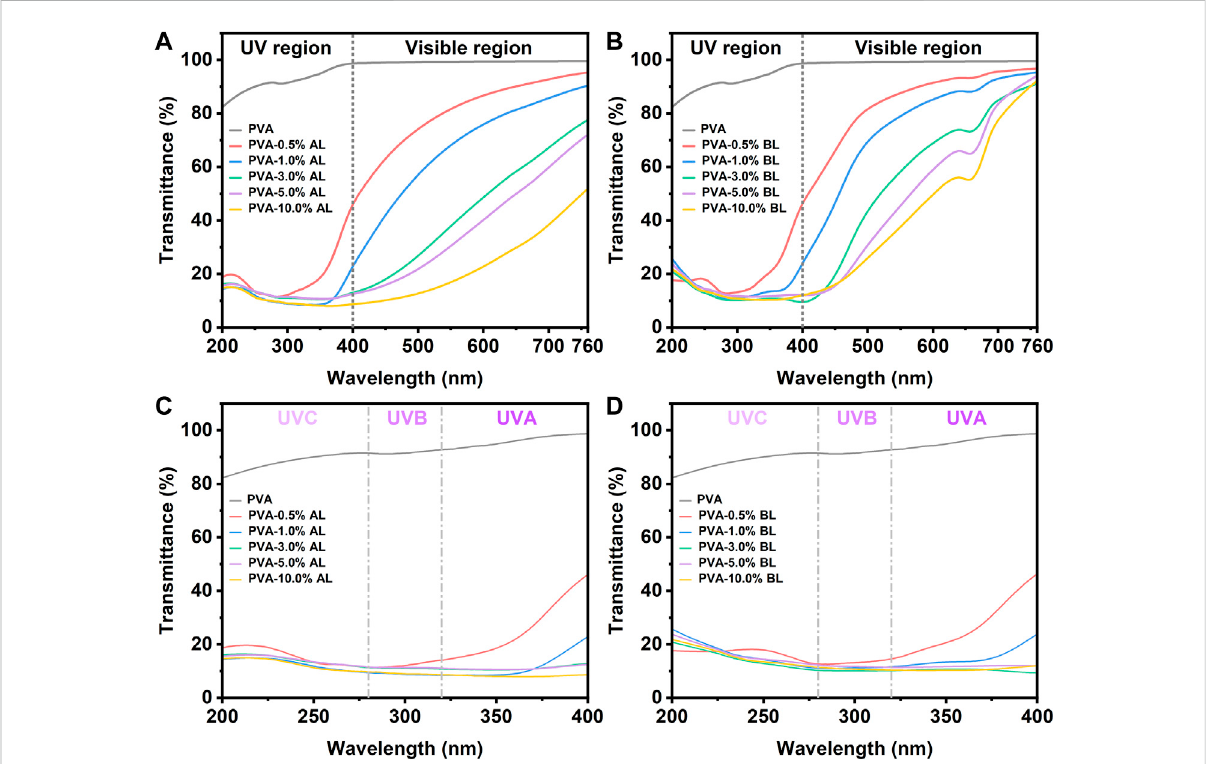
FIGURE 1 Light transmittance of PVA, PVA/AL, and PVA/BL fi lms. (A) 200 – 760 nm AL; (B) 200 – 760 nm BL; (C) 200 – 400 nm AL; (D) 200 – 400 nm BL.